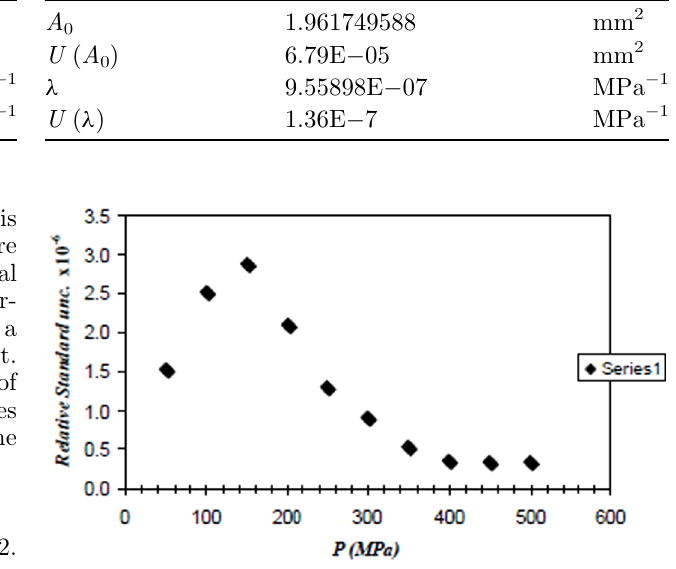
Fig. 6. Results of relative standard uncertainty type A with k =2 from the reference values.